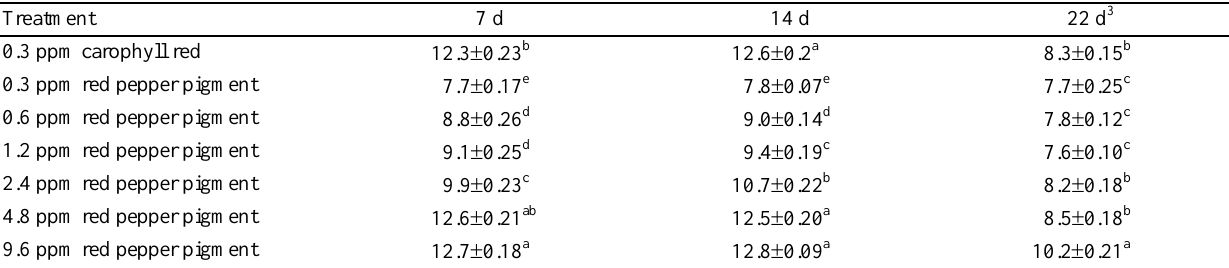
Table 3. Effect of red pepper pigment on the egg yolk color scores of laying hens (Exp. 1) 1, 2